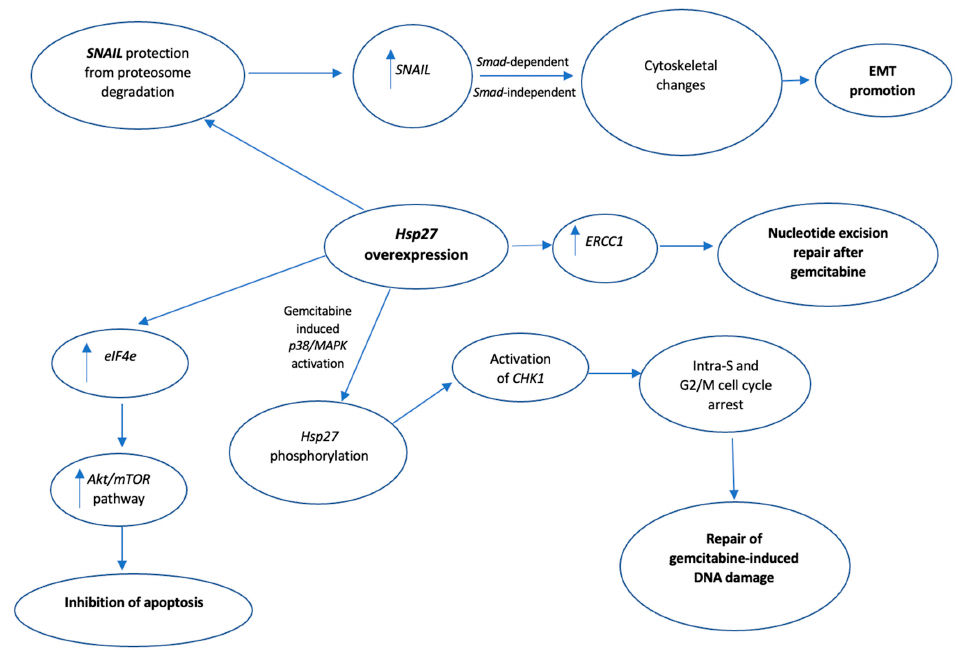
Figure 6. Summary of the proposed mechanisms by which Hsp27 mediates gemcitabine chemo- resistance. Hsp27 overexpression or phosphorylation, through different molecular pathways, results in inhibition of apoptosis, promotion of EMT and repair of gemcitabine-induced DNA damage. Key: SNAIL, zinc finger protein SNAI1; EMT, epithelial to mesenchymal transition; ERCC1, effects of excision repair cross-complementation group 1; mTOR, mammalian target of rapamycin; CHK1, checkpoint kinase 1; eIF4e, eukaryotic translation initiation factor 4E.